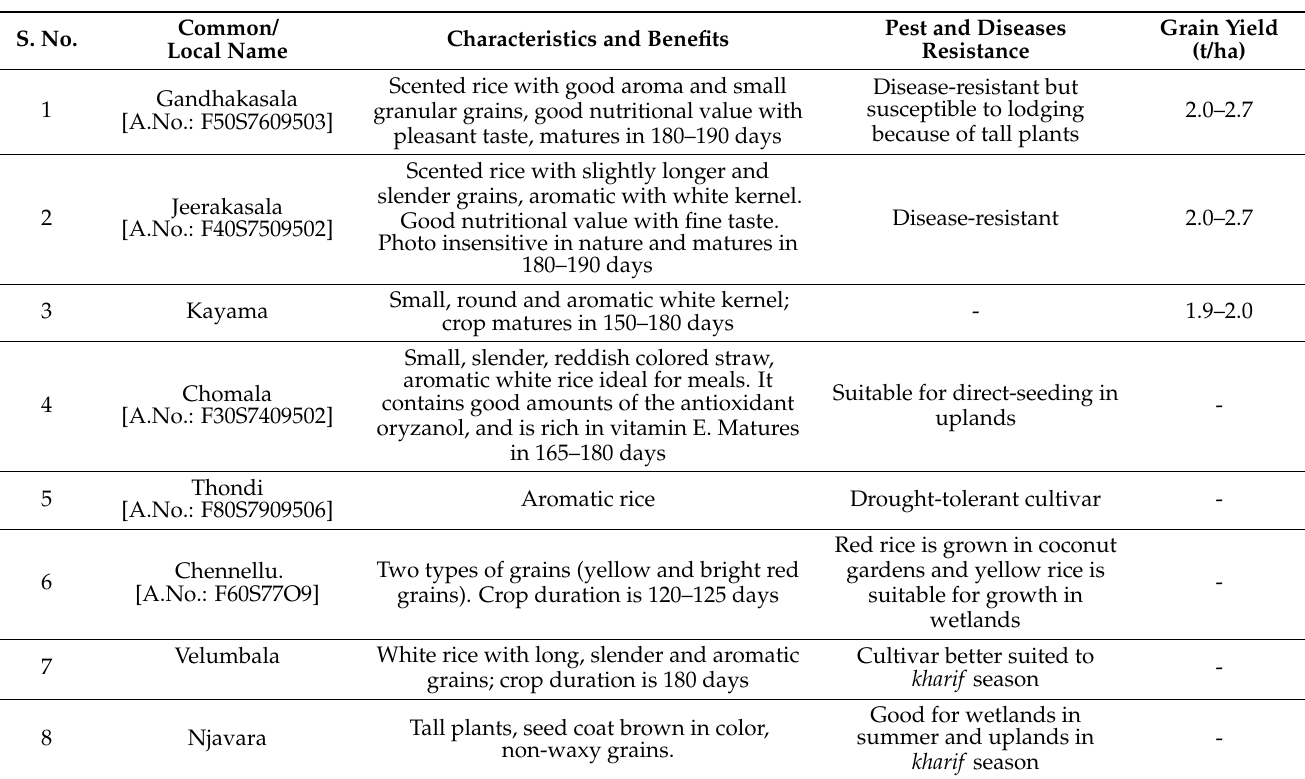
Table 5. Traditional Rice Varieties in Kerala’s Western Ghats